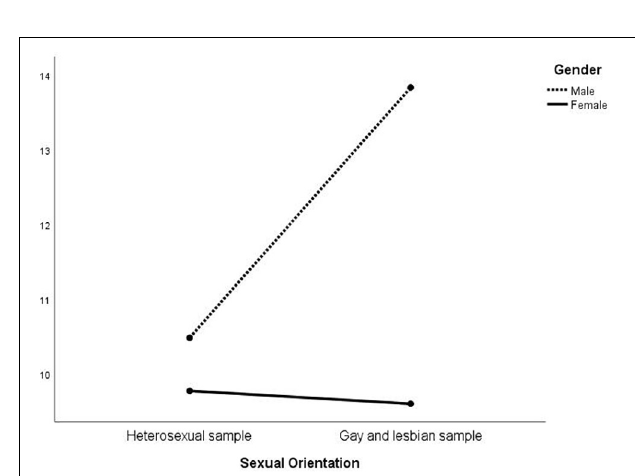
FIGURE 2 | Interaction of gender × sexual orientation on EIQ F2-Emotional and romantic themes.